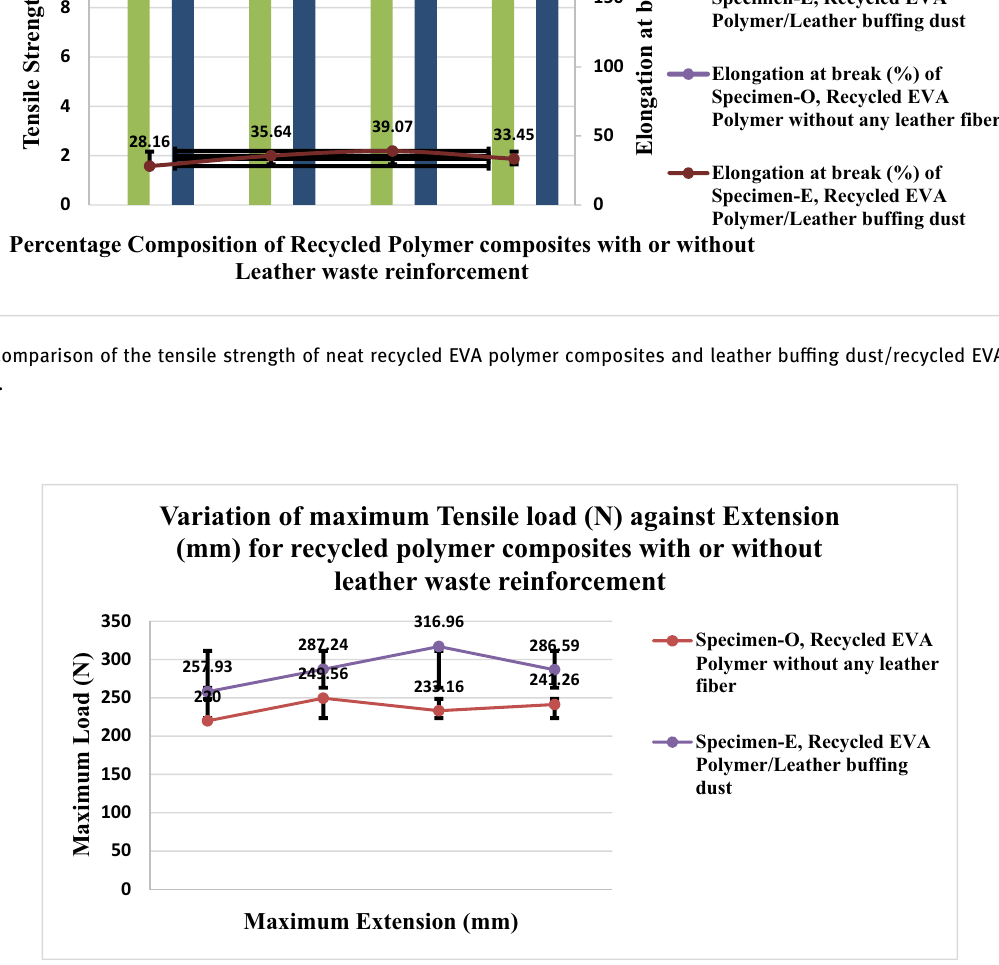
Figure 31: Variation of tensile load ( N ) against extension ( mm ) of recycled EVA polymer composites with or without leather bu ffi ng